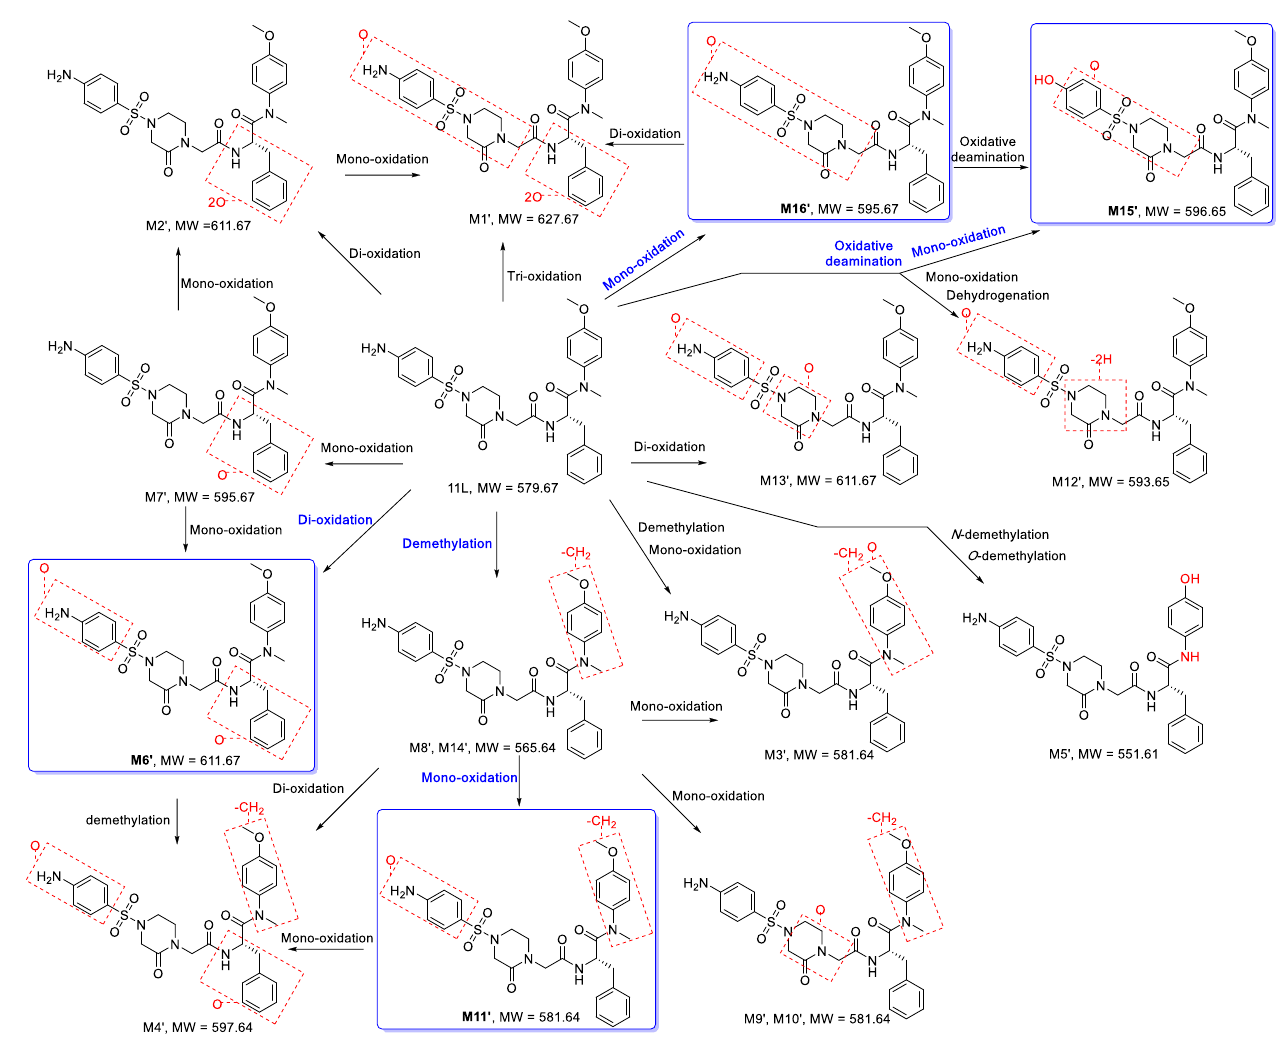
Figure 9. Proposed metabolic pathways of 11L in HLMs. The main pathways are highlighted in blue.